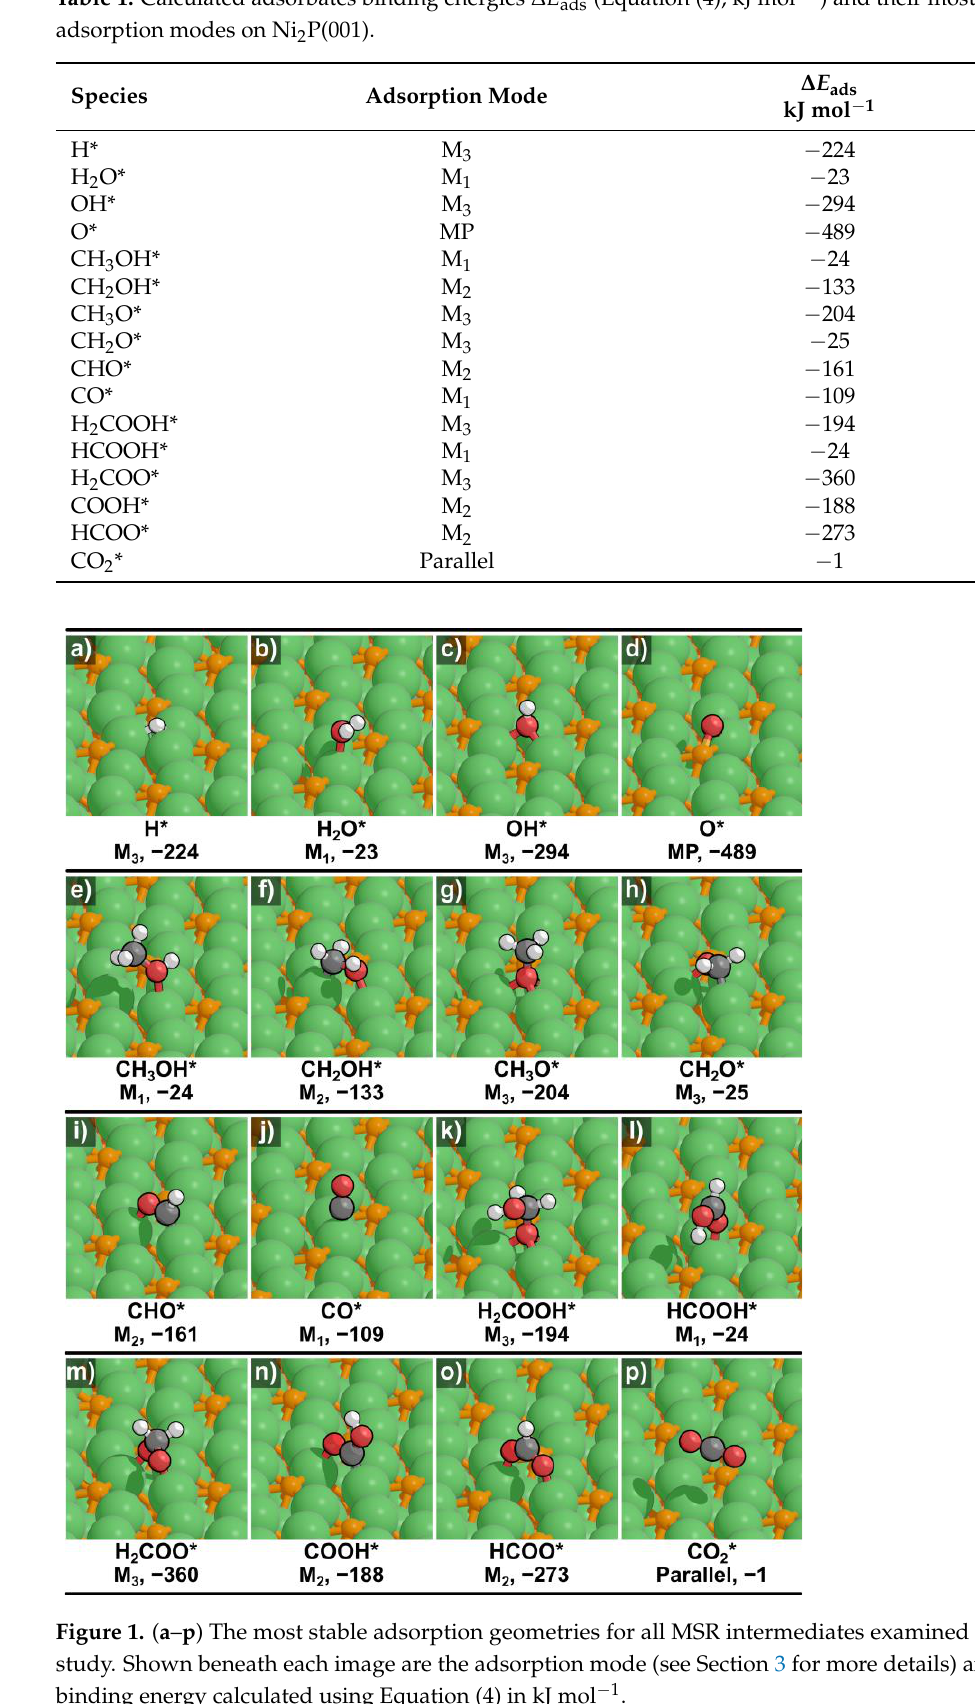
Table 1. Calculated adsorbates binding energies ∆ E ads (Equation (4); kJ mol − 1 ) and their most stable